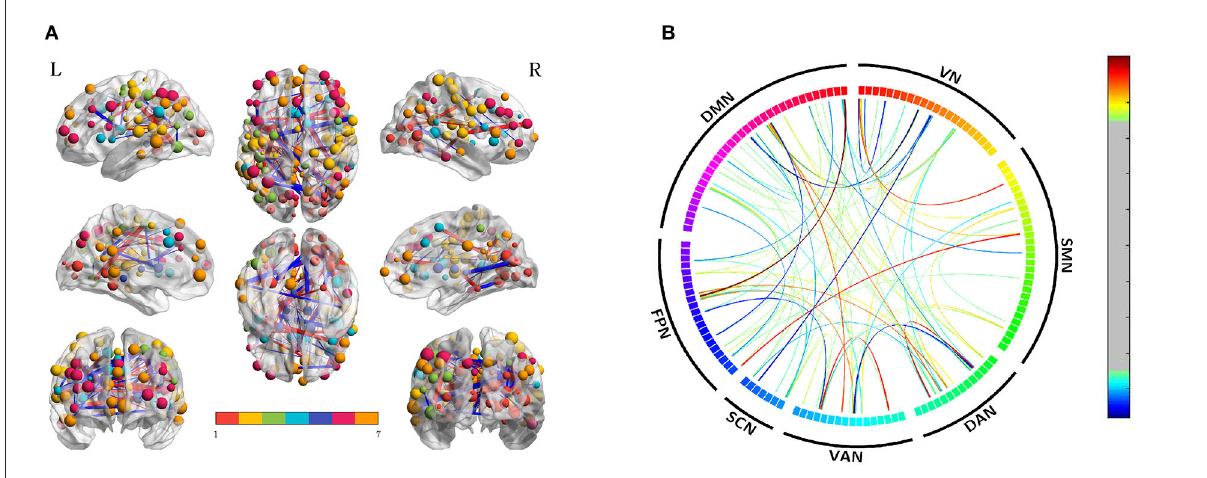
FIGURE4 Altered edge-based functional connectivity between the acute SD after acupuncture and RW state. (A) The brain maps show the affected edges (lines) and their connecting nodes (spheres) from several perspectives. The size of a node indicates how many affected edges are connected to this sphere. Bigger nodes have more affected edges than smaller ones. The color of a node indicates which network it belongs to. The warm color of edges indicates the increased FC after acupuncture, while the cold color of edges indicates the decreased FC. (B) ROI to ROI connectivity of seven networks in panels. The result was corrected by NBS ( p < 0.01, two-tailed, permutation with 5,000 iterations). DAN, dorsal attention network; DMN, default mode network; FC, functional connectivity; FPN, frontoparietal network; L, left; R, right; SCN, subcortical network; SMN, somatosensory network; VAN, ventral attention network; VN, visual network; RW, rested wakefulness.